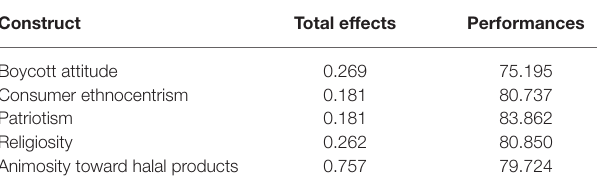
TABLE 4 | Importance-performance map analysis.